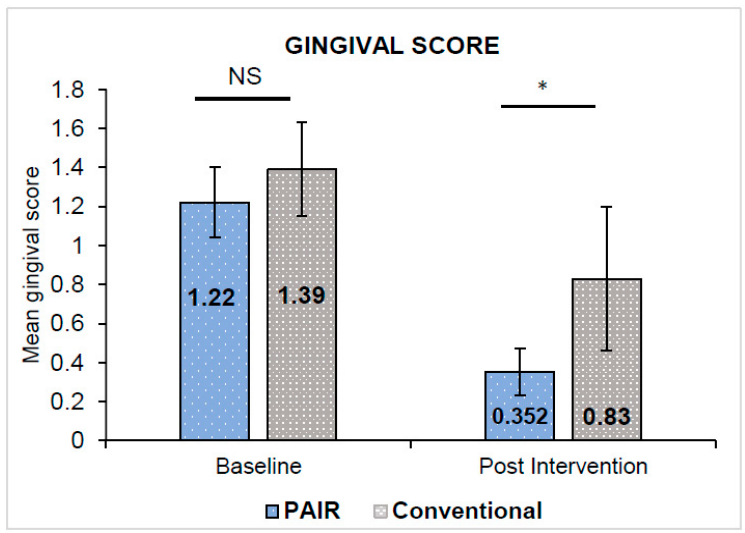
Figure 3. Comparison of mean gingival score in PAIR technique group and conventional technique group. All values are expressed as mean ± standard deviation. The statistical test used: Unpaired t -test; * Statistically significant, p ≤ 0.05; NS: not significant.